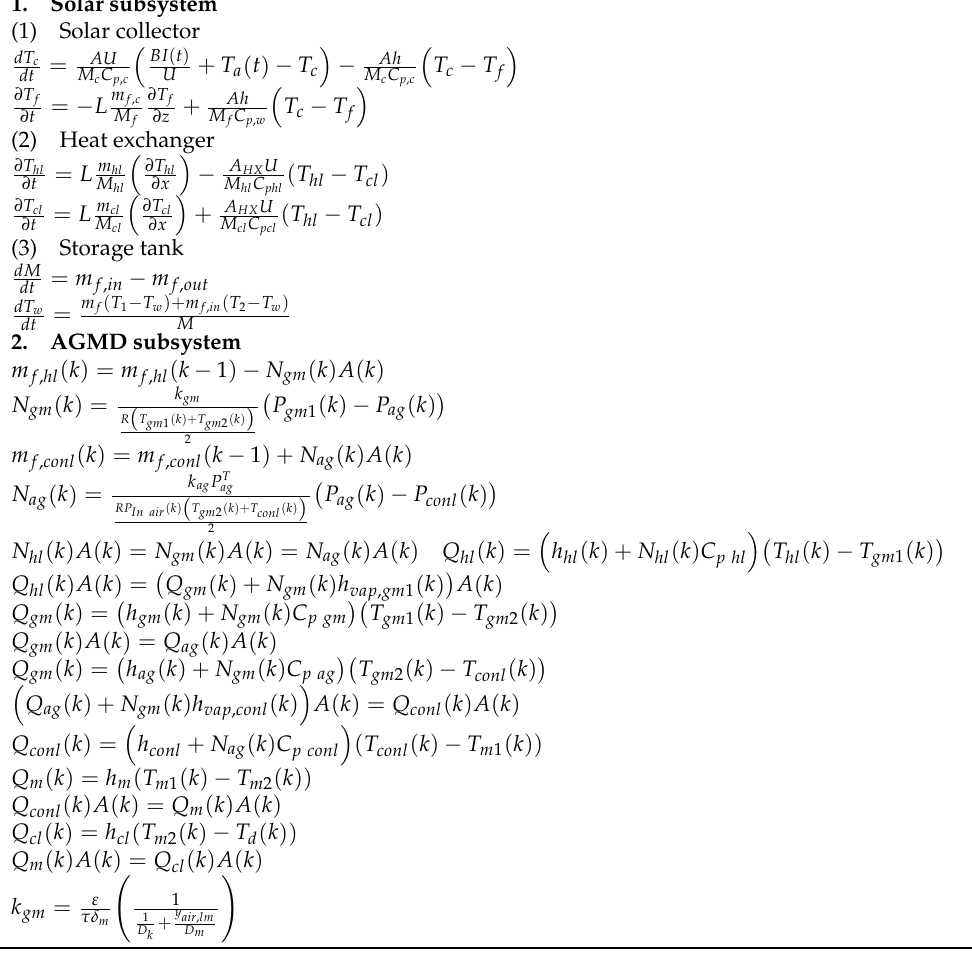
Table 1. Model equations for each unit of solar-driven MD systems for